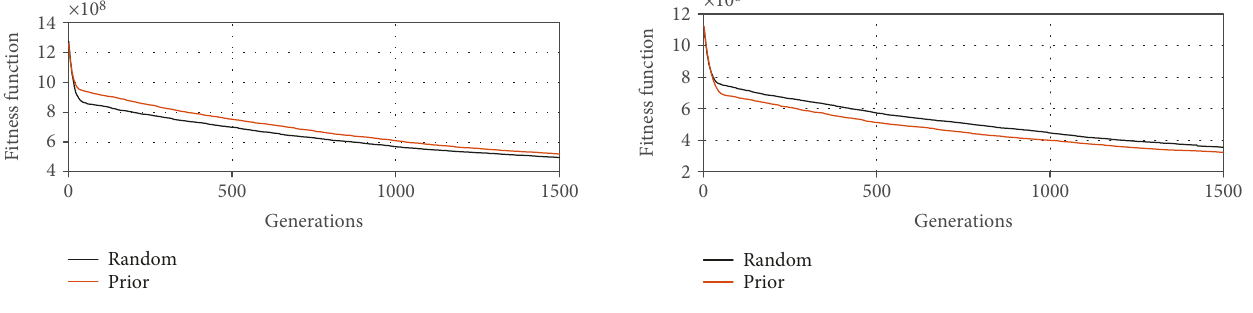
Figure 9: Evolution of the fi tness function of strategy 2 through generations.